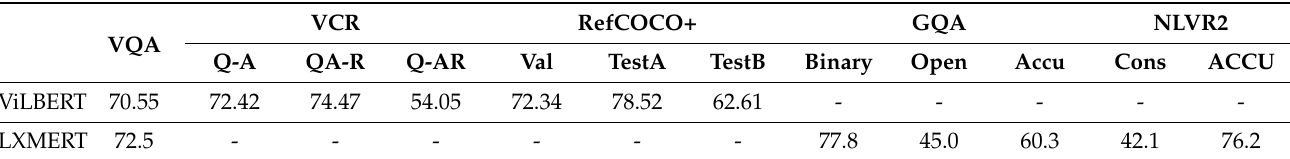
Table 8. Evaluation results of ViLBERT and LXMERT on selected public